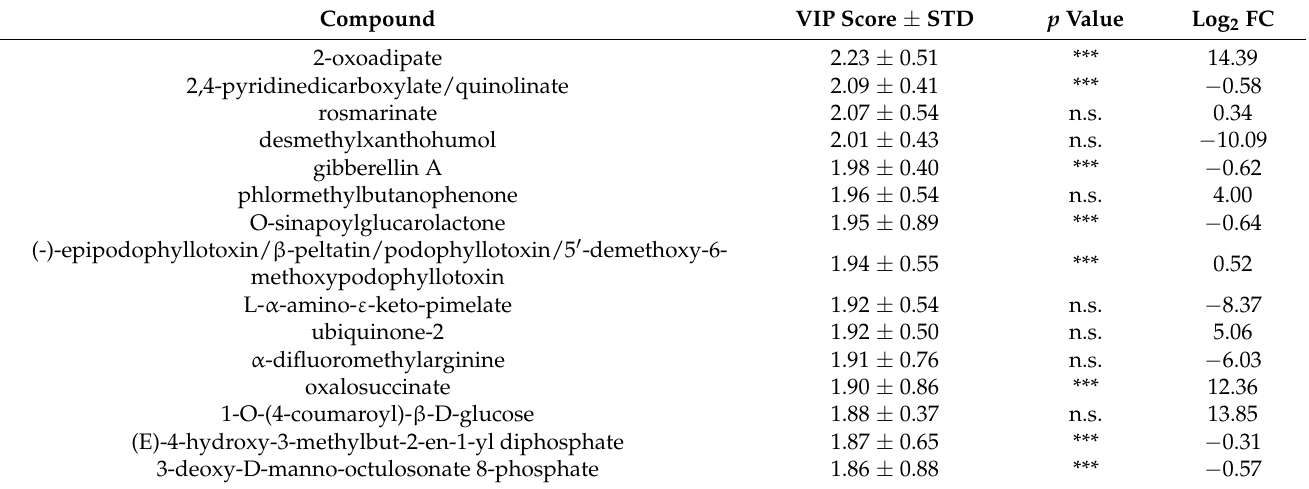
Table 1. Leaf metabolic markers, according to their VIP score ± standard deviation (STD), related to the OPLS-DA model in Figure 2a (effect of UV treatment). Compounds are provided with p value and their Log 2 FC calculated with respect to control samples. * p ≤ 0.05, ** p < 0.01, *** p < 0.001, n.s., not significant.